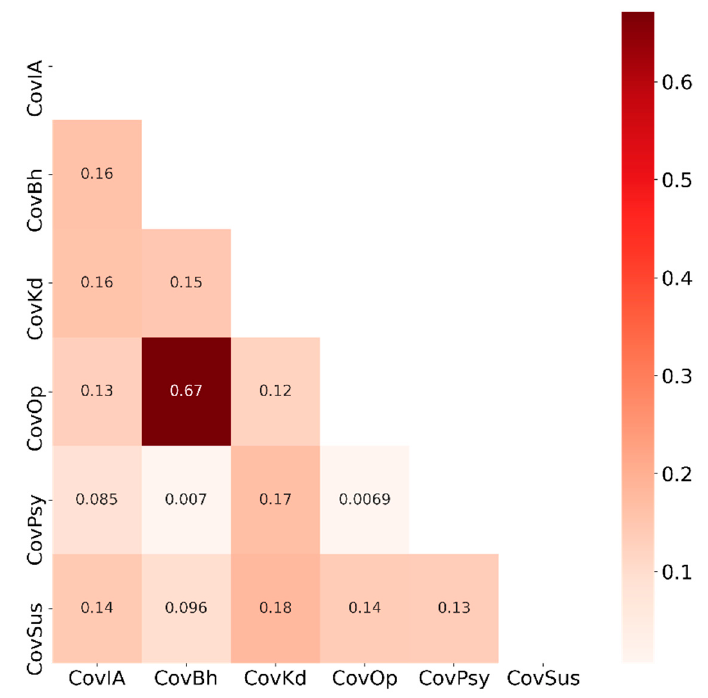
Figure 5. Correlation analysis of different COVID-19 metric scores for accessibility (CovIA), behavior (CovBh), knowledge (CovKd), opinion (CovOp), psychosocial health (CovPsy), and susceptibility (CovSus).